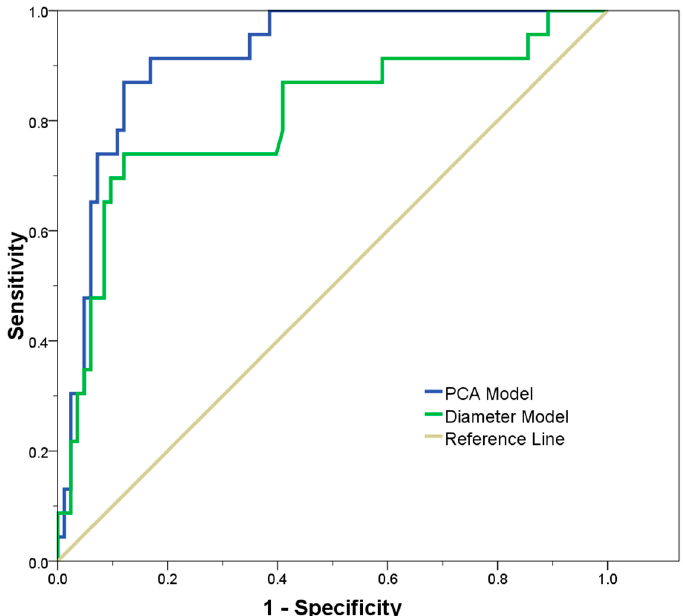
Figure 7. ROC curves for predicting the risk of surgery using a model based on principal shape modes as compared to the baseline model based on maximum aortic diameter.